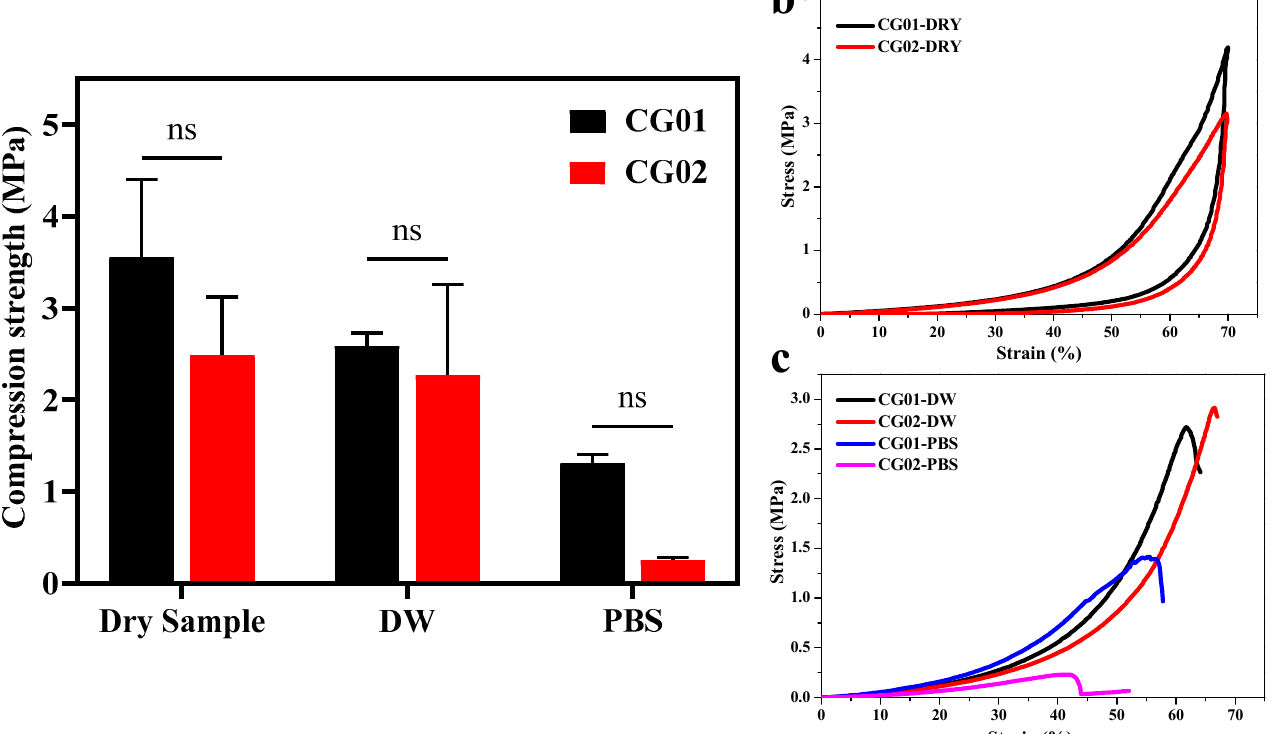
Figure 7. The compressive test analysis of hydrogels in wet and dry conditions (the samples were immersed in water or PBS for wet samples ( a ) compressive strength of CG01 and CG02 hydrogels at different conditions, and ( b ) stress-strain behavior of dry samples, ( c ) stress-strain curve of samples in wet conditions. (DW—Distilled water, PBS—Phosphate-buffered saline). The results are non- significant (ns) in compared to CG02.